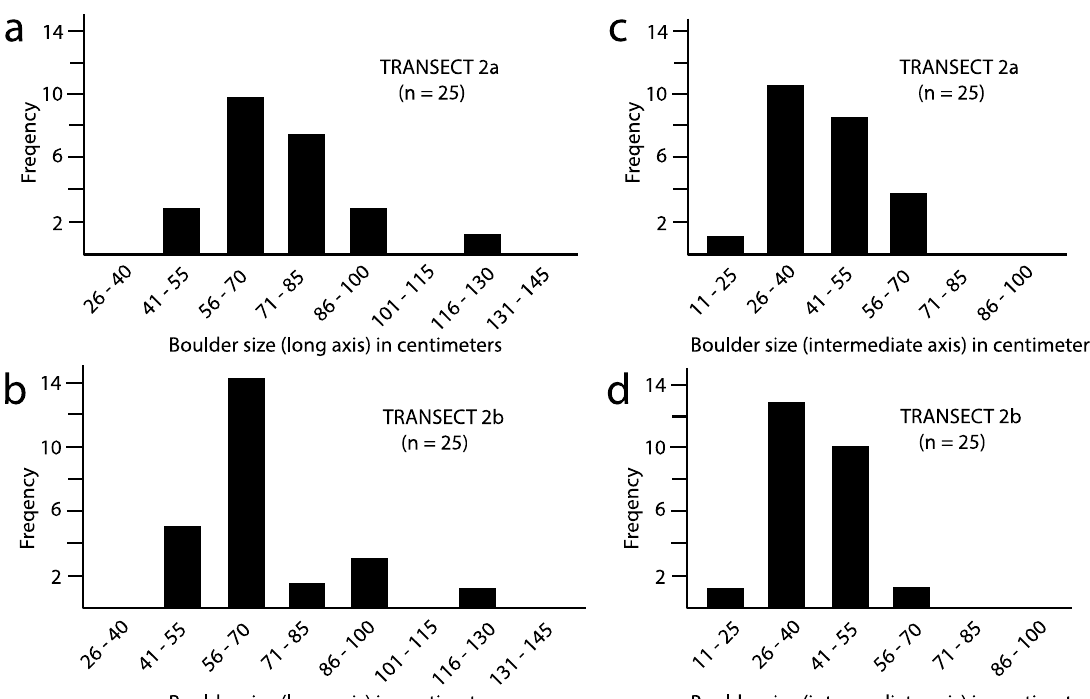
Figure 10. Parallel sets of bar graphs used to appraise variations in the log and intermediate axes on